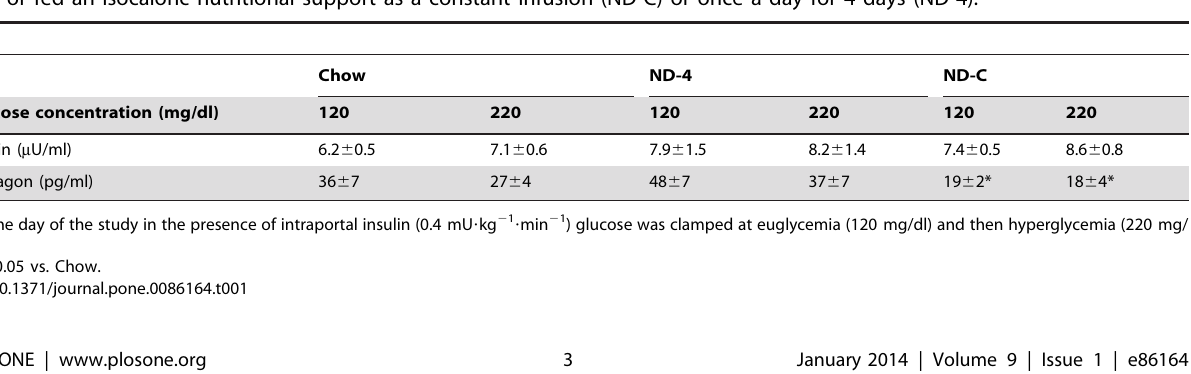
Table 1. Arterial plasma insulin and glucagon in chronically catheterized conscious insulin-treated depancreatized dogs on a chow diet or fed an isocaloric nutritional support as a constant infusion (ND-C) or once a day for 4 days (ND-4).